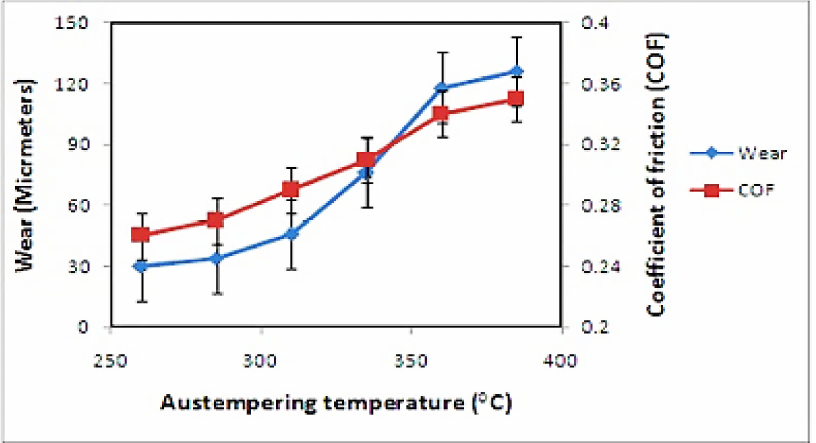
Figure 32. Effectiveness of austempering temperature on tribological behavior of the samples